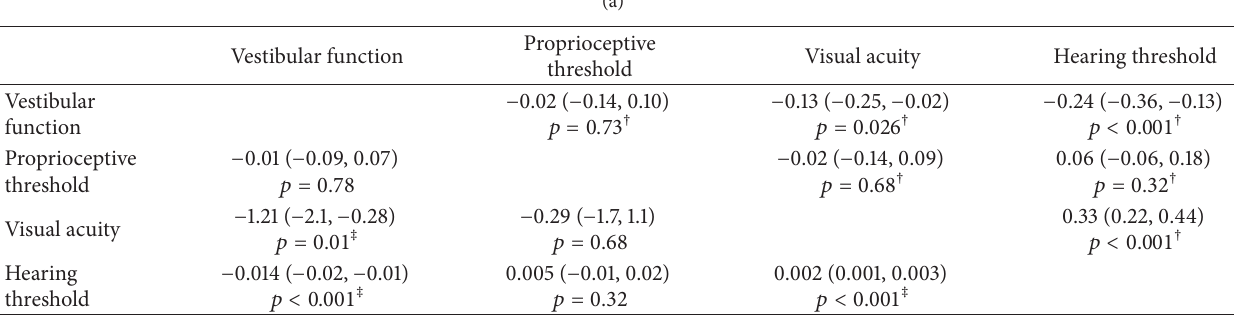
Regression coefficients refer to change in the column variable associated with 1 unit change in row variable for bottom half of table. † represents normalized regression coefficients corresponding to bottom half of table. 95 % confidence intervals are included in parentheses. The units for the variables are vestibular function (VOR gain ratio), proprioceptive threshold (degrees), visual acuity (LogMAR), and hearing threshold (dB). ‡ = 𝑝 value < 0.05.